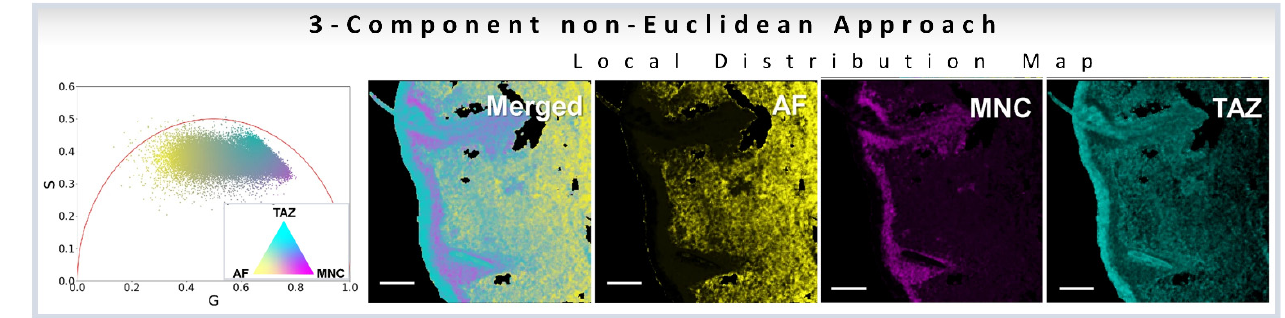
Figure 11. Quantification and visualization of minocycline (MNC), tazarotene (TAZ) in ex vivo skin samples. Quantification of the drug distribution for the three components: MNC, TAZ and autofluorescence based on the ono-Euclidean geometry results in distribution patterns for the three components, as shown by yellow for AF, cyan for TAZ, and magenta for MNC, respectively. The scale bar is 100 μ m. (Figure adapted from [36]).